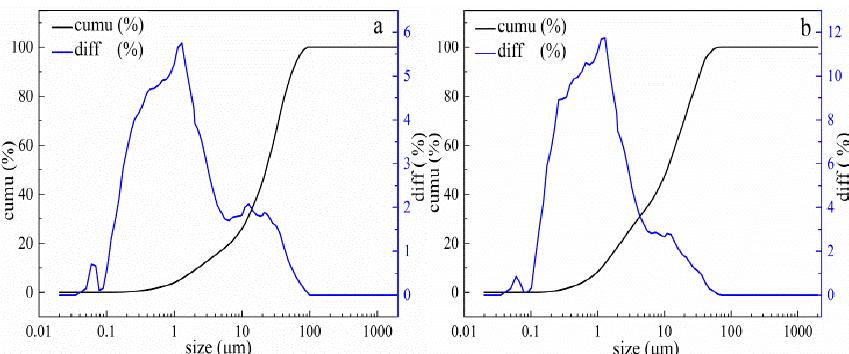
Figure 16. Size distribution of lead residues under conventional and ultrasonic conditions. ( a ): under